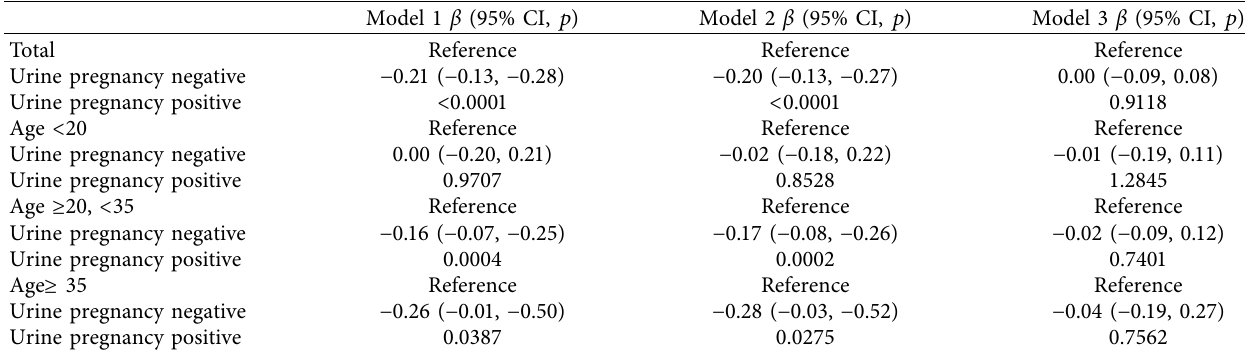
Table 5: Associations between urine pregnancy test and serum glucose (mmol/L) in nondiabetes